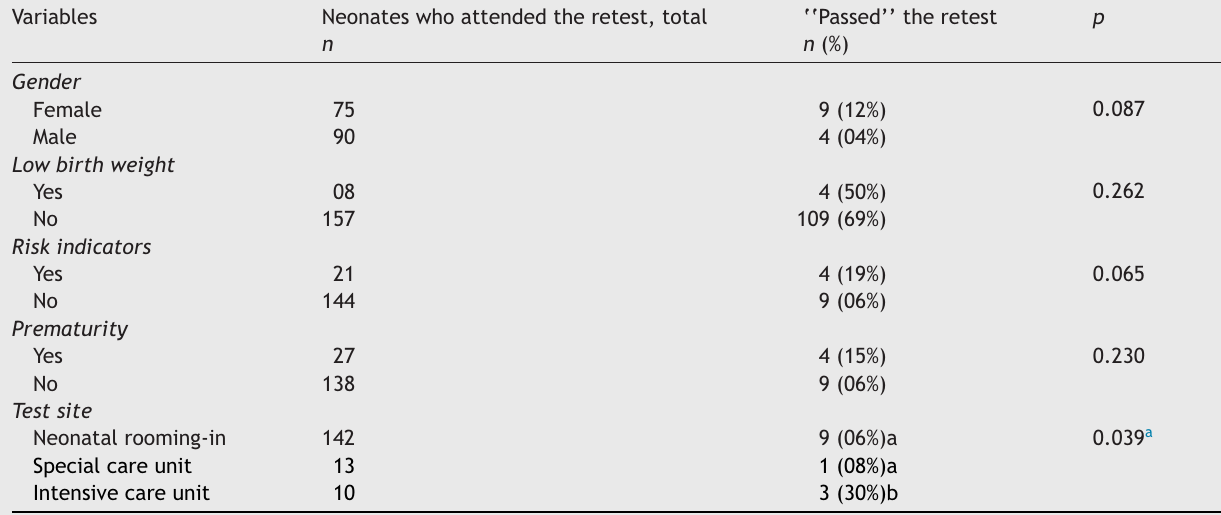
Relationship between maintenance of retest ‘‘failure’’ in at least one ear and the following variables: gender, low birth weight, risk factors, prematurity and test